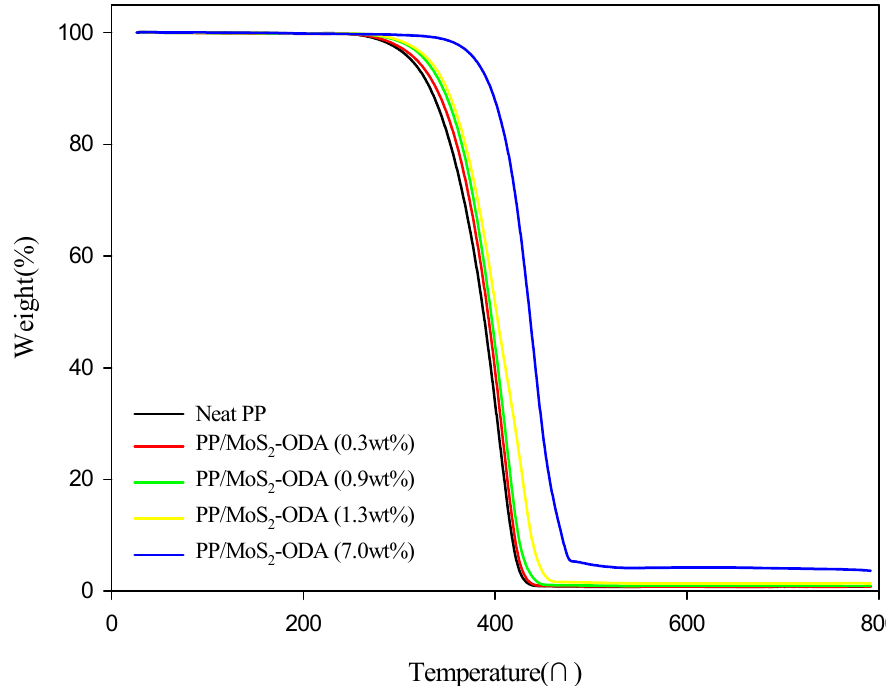
Figure 5. Thermogravimetric analysis (TGA) curves of neat PP and PP / MoS 2 -ODA nanocomposites with various MoS 2 -ODA contents. Table 3. Thermal stability of PP / MoS 2 -ODA composites at various contents of 2D-nanosheet.